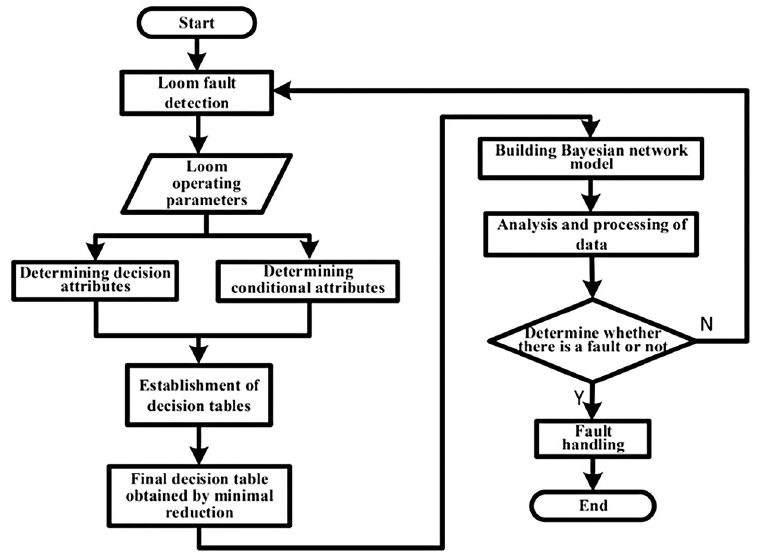
Fig 3. Block diagram of the fault diagnosis